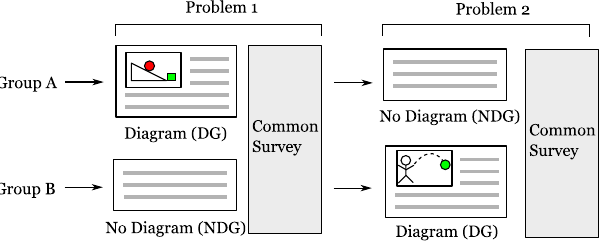
FIG. 1. Experiment design. Each experiment consisted of a pair of problems. The same design was used for all 6 experiments